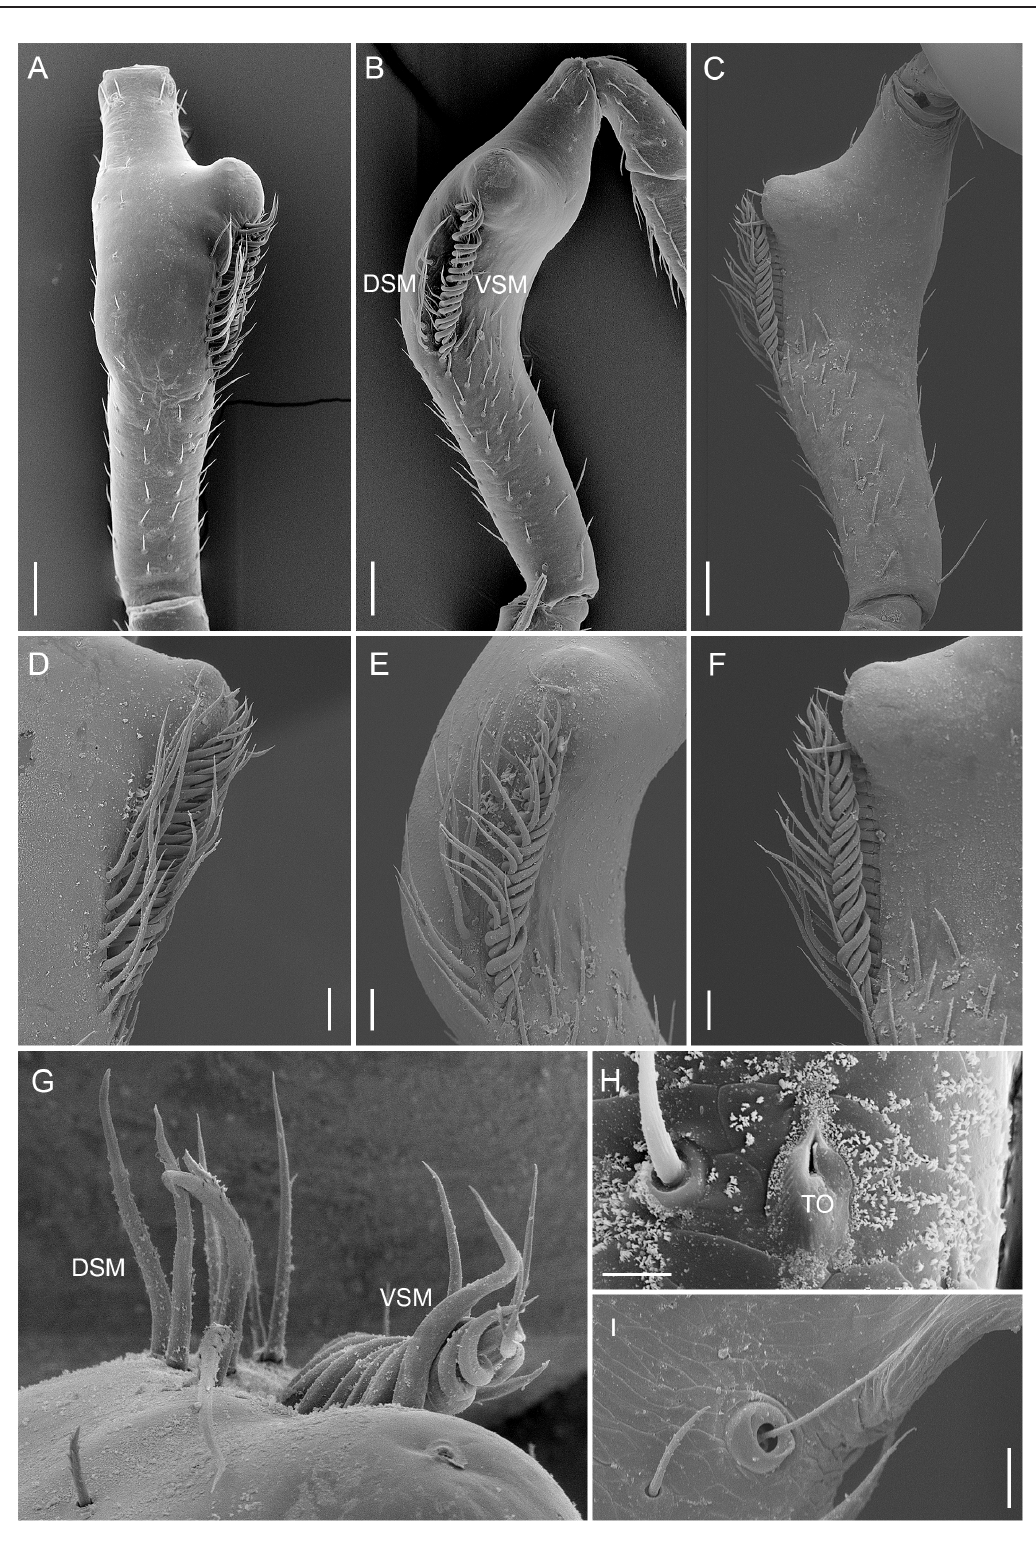
Fig. 4. Xim trenzado gen. et sp. nov. A–B . ECOTAAR-004950. C–F, H–I . ECOTAAR-004962. G . ECOTAAR-004952. A–G . Male left femur I. D–G . Details of macrosetae. A, D . Dorsal view. B, E . Prolateral view. C, F . Ventral view. G . Apical view. H . Tarsal organ of leg I. I . Trichobothrium of retrolateral palpal tibia. Scale bars: A–C = 70 μm; D–F = 30 μm; H = 5 μm; I = 10